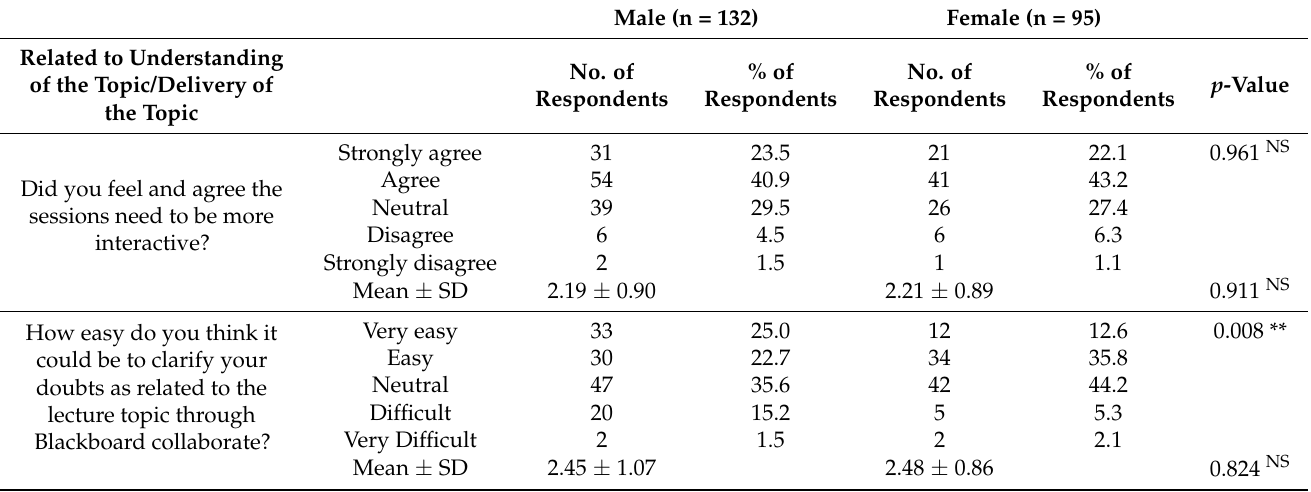
Table 8. Distribution of responses related to understanding of the topic/delivery of the topic accord- ing to